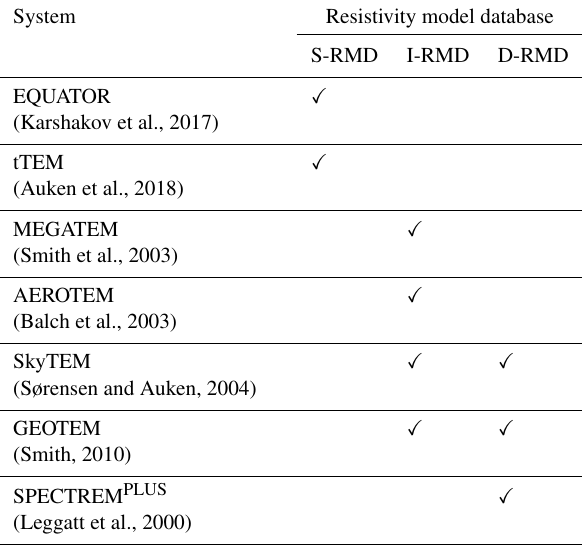
Table 4. Examples of DL-RMD compatibility for some TEM sys-